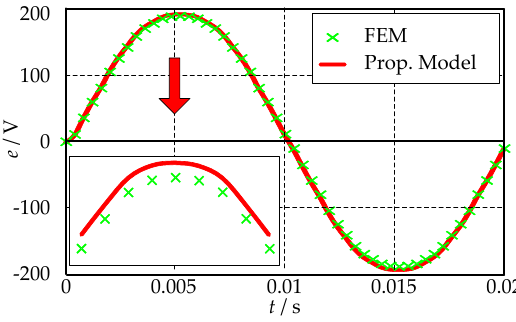
Figure 8. Phase electromotive force (EMF) of the proposed DRRF generator at no load.